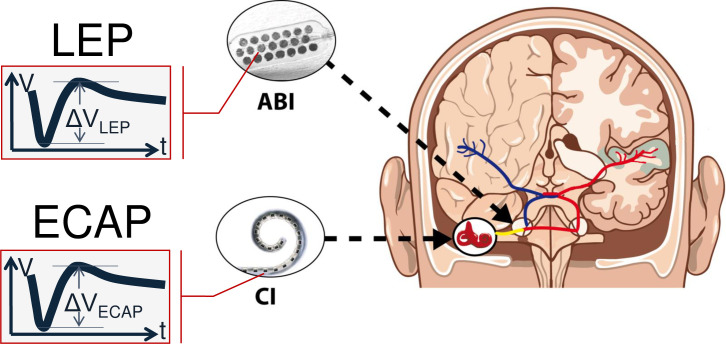
Schematic diagram of ECAP measurements in CI patients and LEP measurements in ABI patients.For illustration purposes, an arbitrary response (voltage V over time t) is shown. With respect to the different locations of stimulation and recording, responses from an ABI are called “Local Evoked Potentials” (LEP).